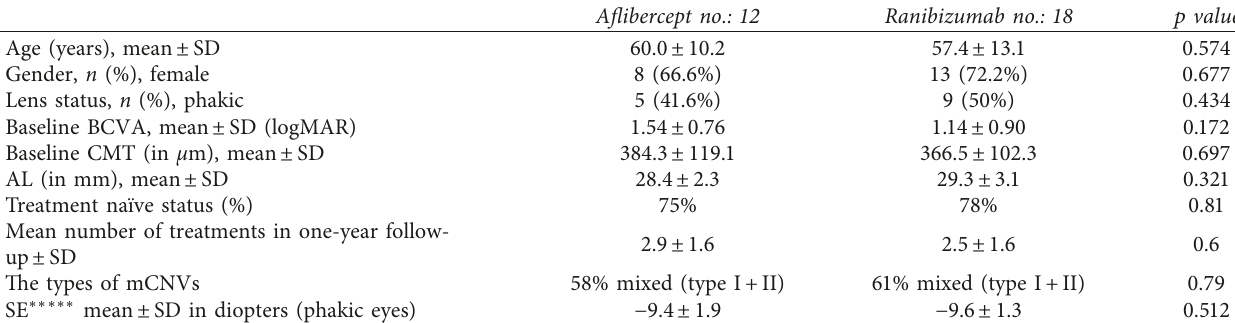
Table 1: The baseline clinical and demographic characteristics of both groups were found statistically comparable in all parameters. Aflibercept no.: 12 Ranibizumab no.: 18